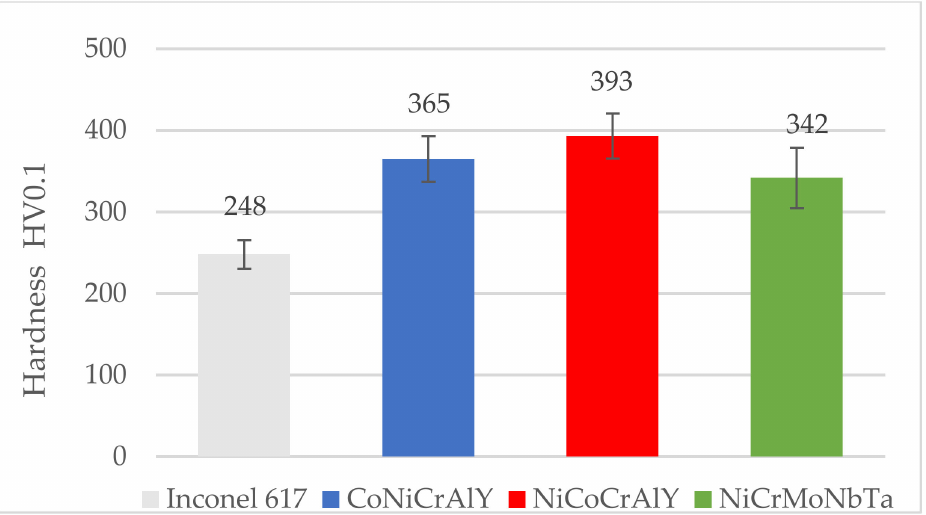
Figure 7. Hardness variability of coatings and the